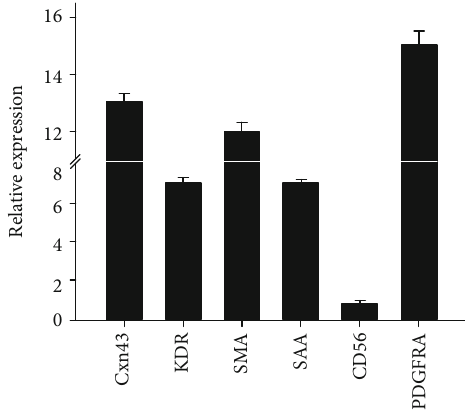
Figure 8: Molecular phenotype of engineered cardiac grafts. Quantitative polymer chain reaction was utilized to assess the molecular phenotype of fully constituted, implantation-ready engineered cardiac grafts ( n = 2 ). The phenotype is de fi ned by expression of connexin 43 (Cxn43), kinase insert domain receptor (KDR), smooth muscle actin (SMA), sarcomeric alpha actinin (SAA), CD56, and platelet-derived growth factor receptor- α (PDGFRA). Grafts were composed of hiPSC-CMs and human fi broblasts on a bioabsorbable construct. Data are reported relative to a fi broblast-only cardiac graft as a